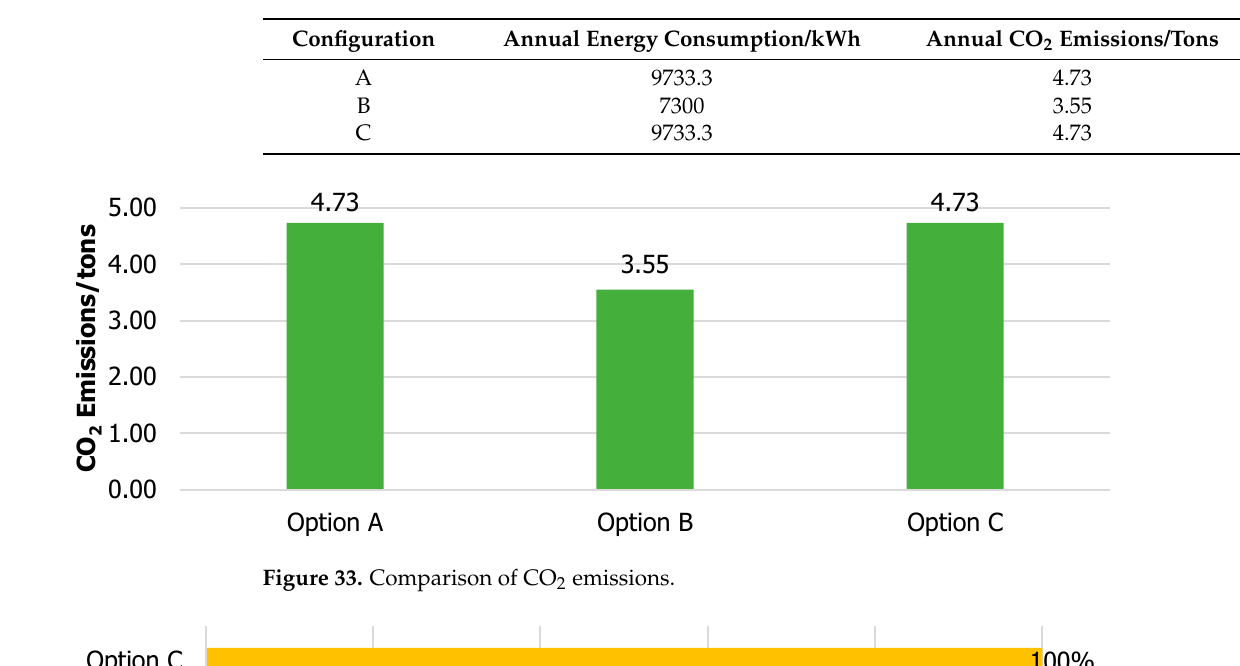
Table 3. Annual energy consumption and CO 2 emissions for three tested configurations.